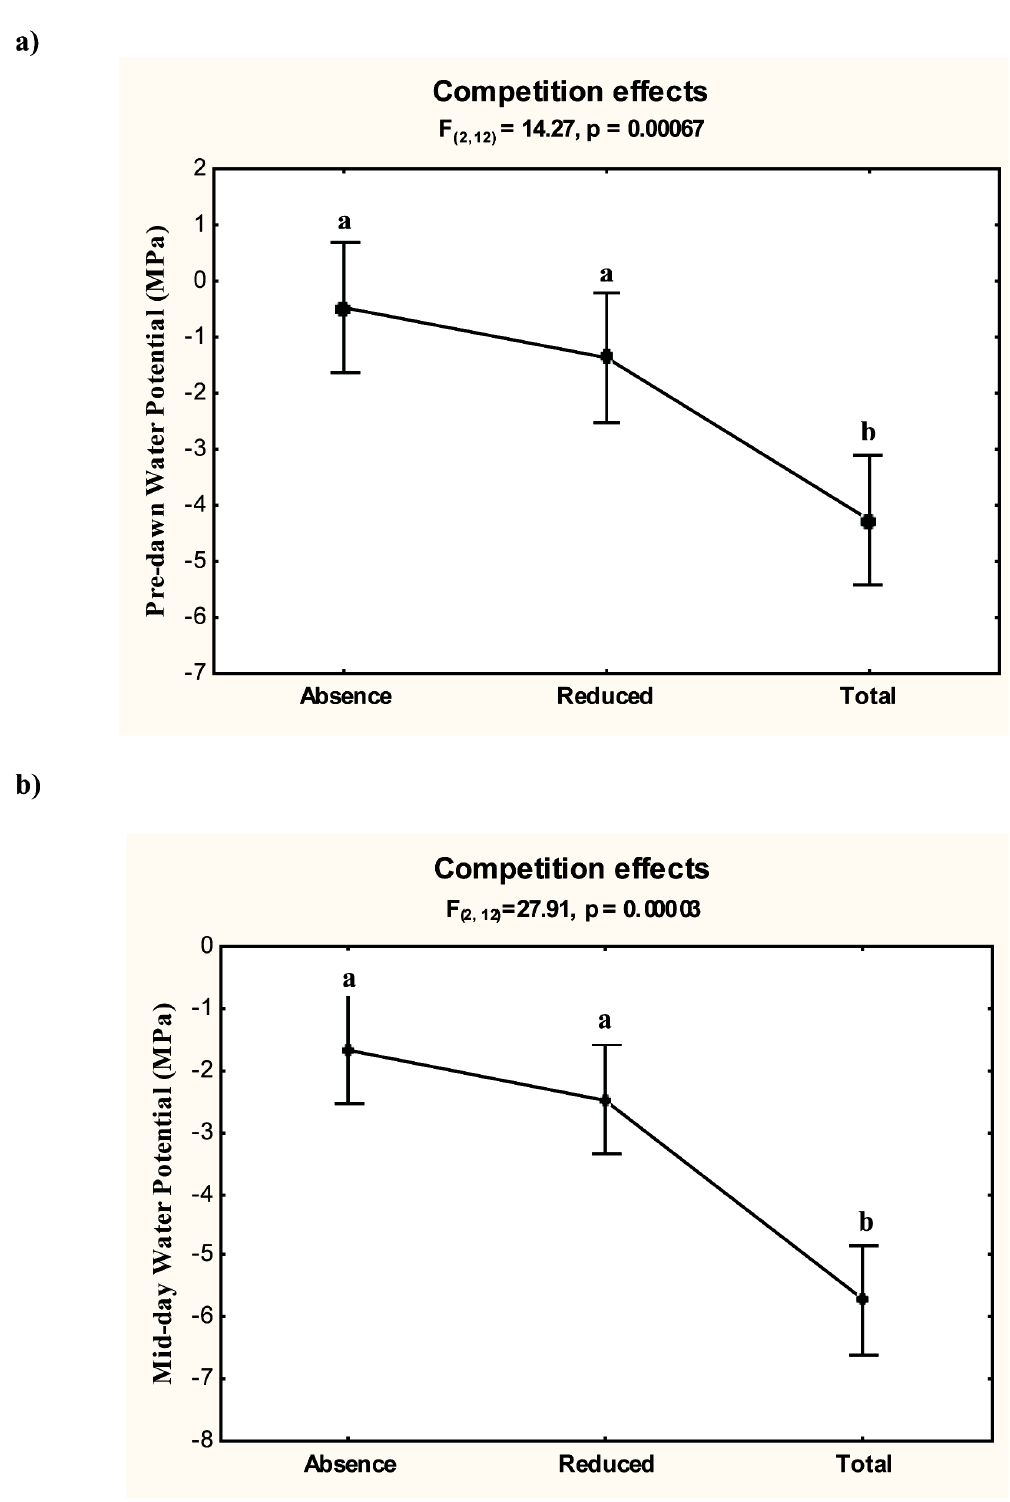
Fig. 4. Variation of pre-dawn (a) and mid-day (b) water potential at each weed competition treatment. The comparison between treatments is based on Tukey´s post-hoc tests (nominal p-value < 0.05). Bars are standard